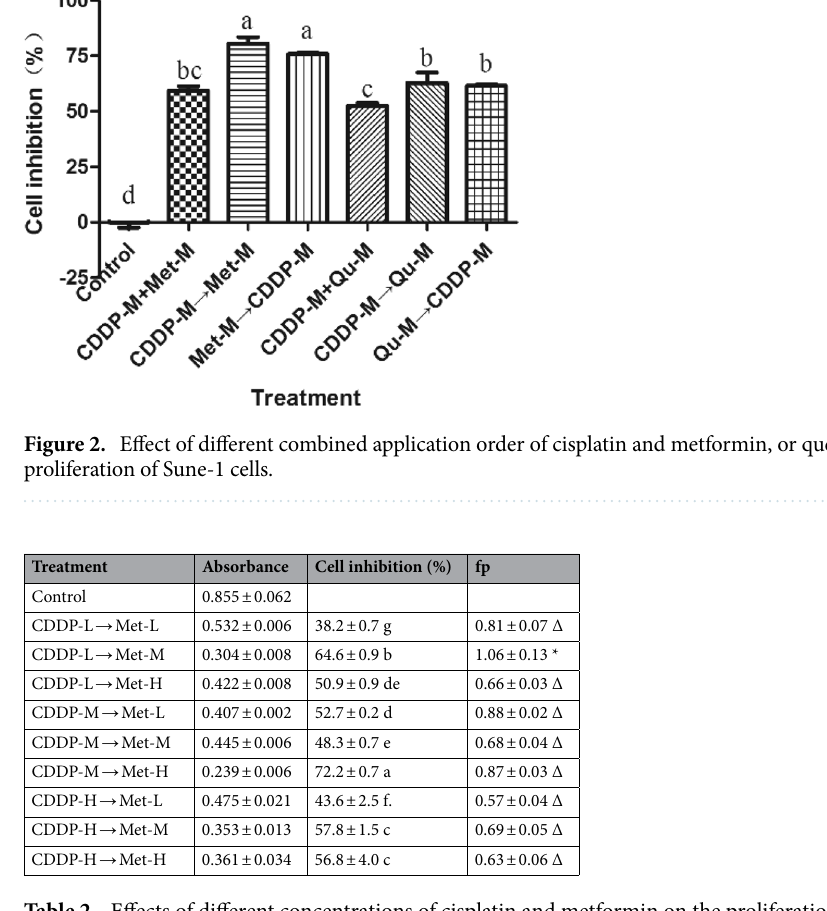
Table 2. Effects of different concentrations of cisplatin and metformin on the proliferation of Sune-1 cells. Δ indicates that the combined effect of the two drugs is antagonistic; * indicates that the combined effect of the two drugs is